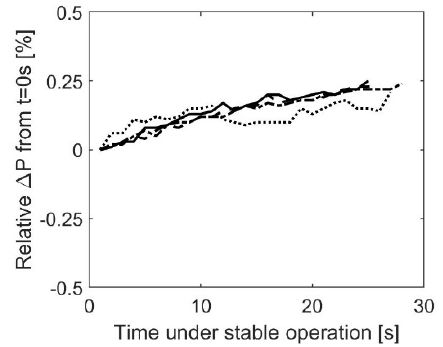
Figure 8. Power output variability for a 10 kW request in discharging operation mode. At t = 0 s, the V2G charger meets the requested power set point and is working in stable conditions. The duration of the tests varies slightly, as the 30 s time period between requests includes the communication (which is slightly variable) and ramping times.